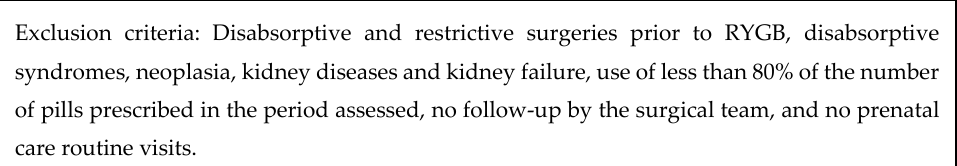
Figure 1. Description of postoperative times, inclusion and exclusion criteria.